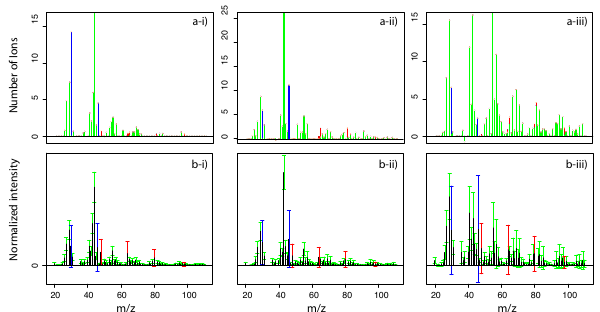
Fig. 5. (a) Example single-particle spectra for (i) cluster I, (ii) clus- ter II, and (iii) cluster III. The particles in (i), (ii), and (iii) were collected on 16 May ( d va = 507nm, d g = 362nm), 31 May ( d va = 402nm, d g = 287nm), and 16 May ( d va = 492nm, d g = 351nm), respectively. (b) Variability of normalized single-particle spectra for each cluster for this study (15 May to 29 June 2010). In each panel, the black sticks show the average spectrum for the cluster, and the whiskers represent standard deviations (variability) at each m/z . Colors indicate organic (green), nitrate (blue), and sulfate (red) fragments.